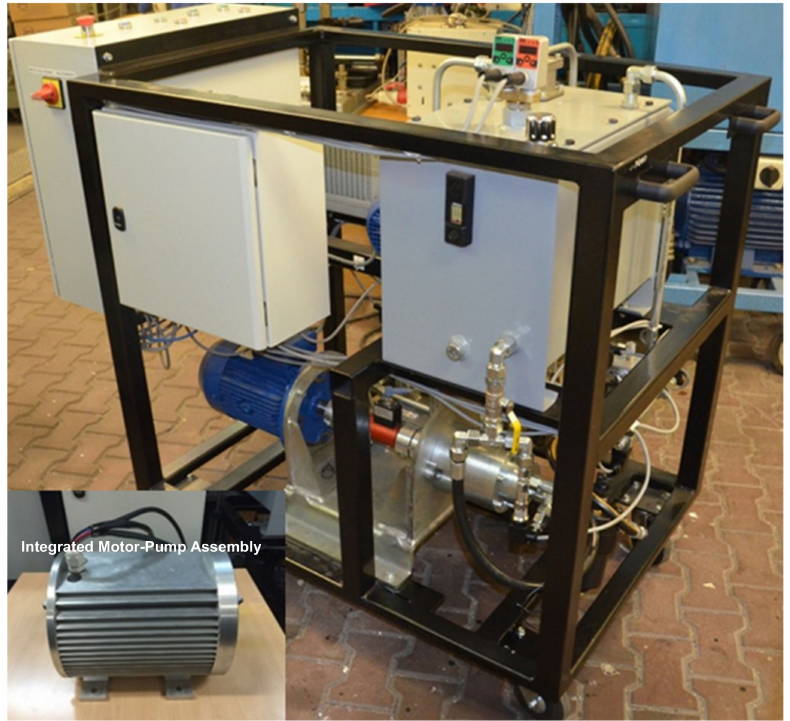
Figure 7. View of the test bench.